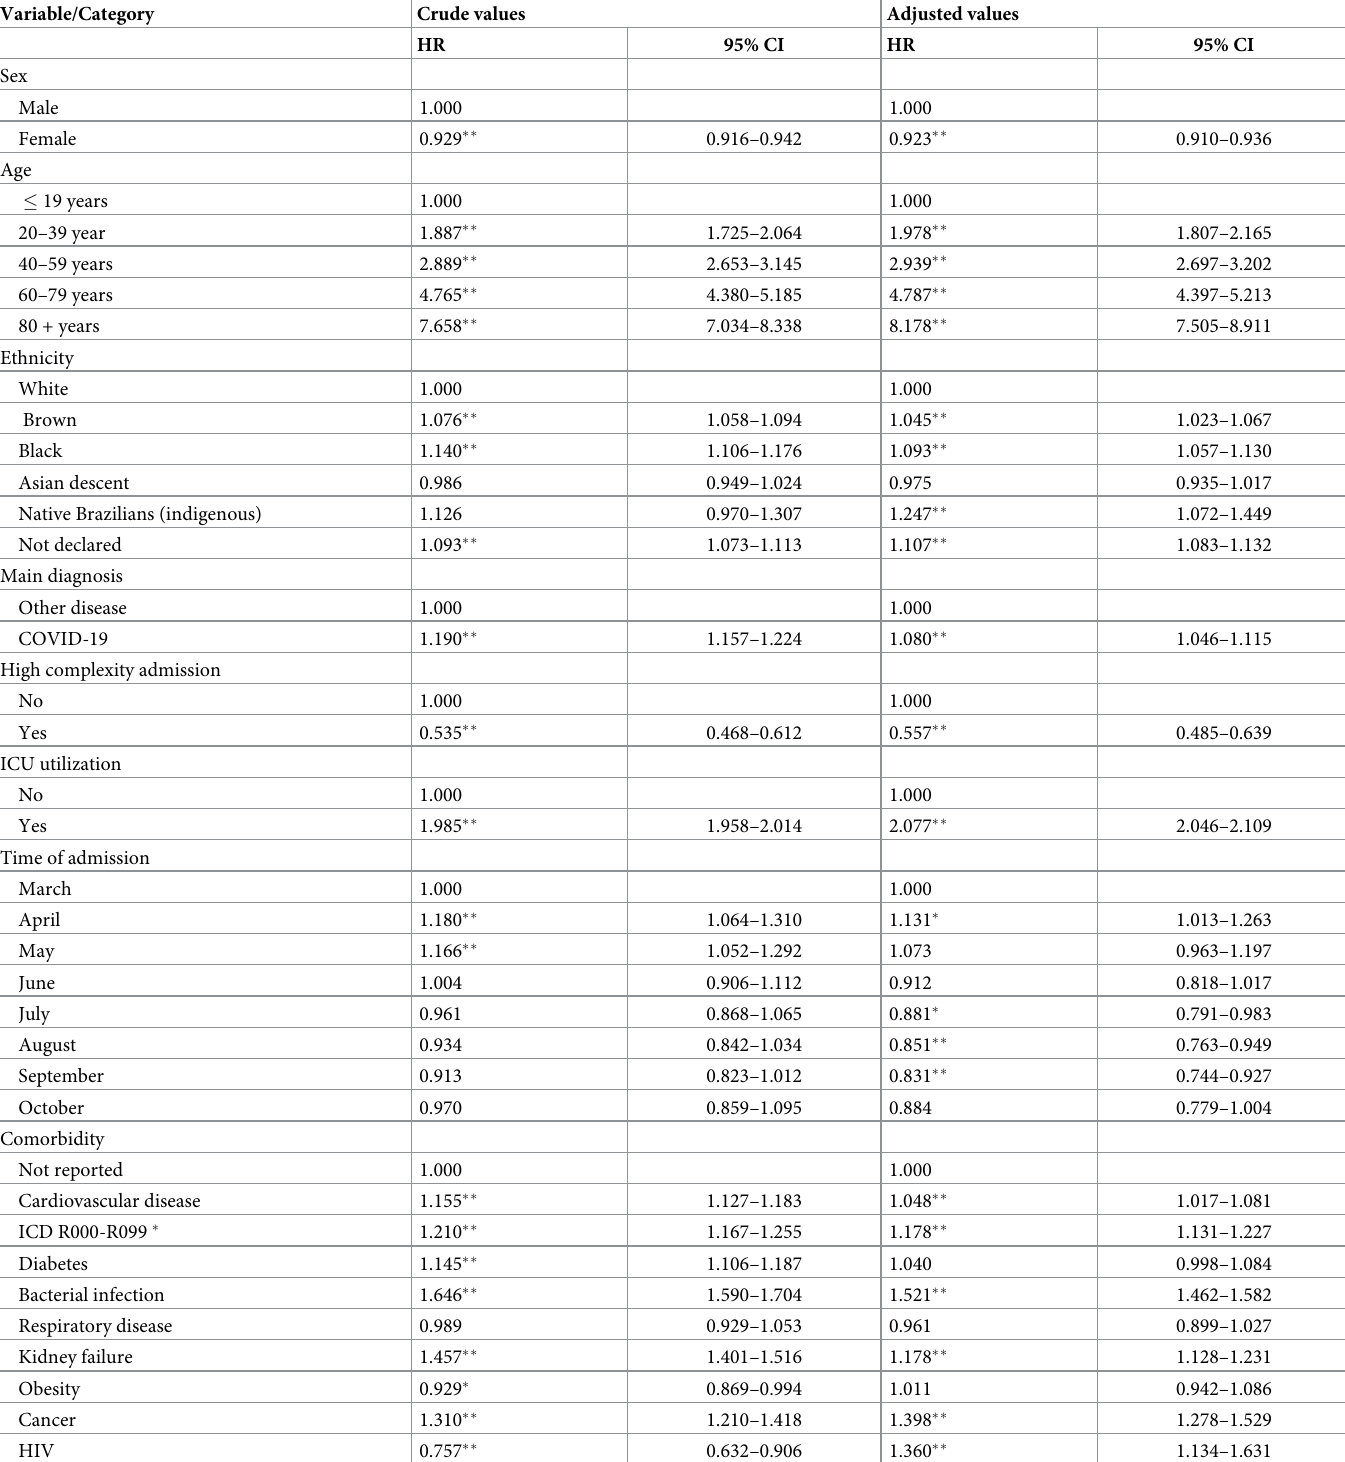
Table 2. Hazard ratios for COVID-19 hospital mortality adjusted for exposure factors in the multivariate Cox regression, Brazil, 1st March to 3rd October